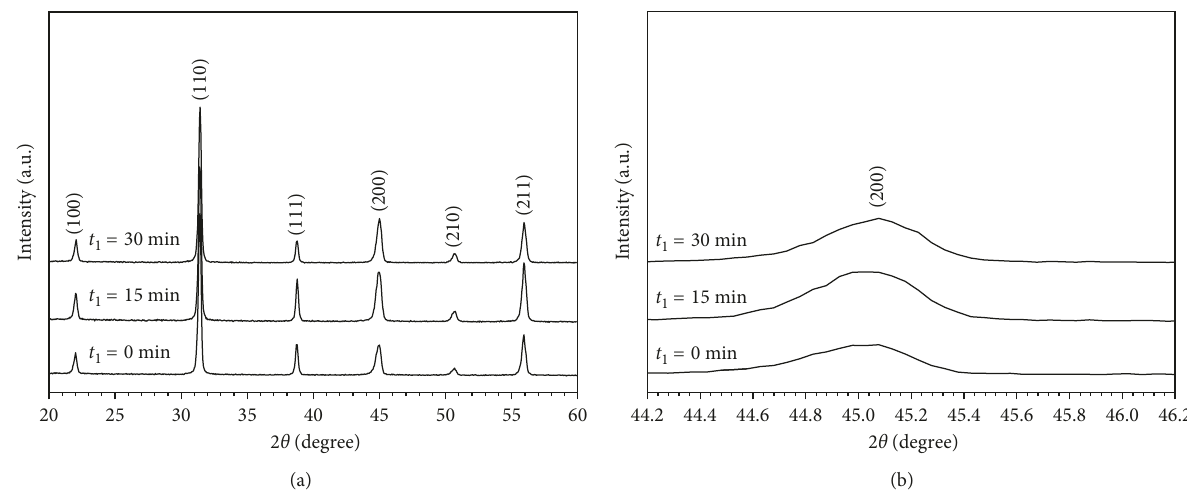
Figure 1: (a) XRD patterns of BTS samples sintered at different dwelling times, t 44.2–46.2 of BTS